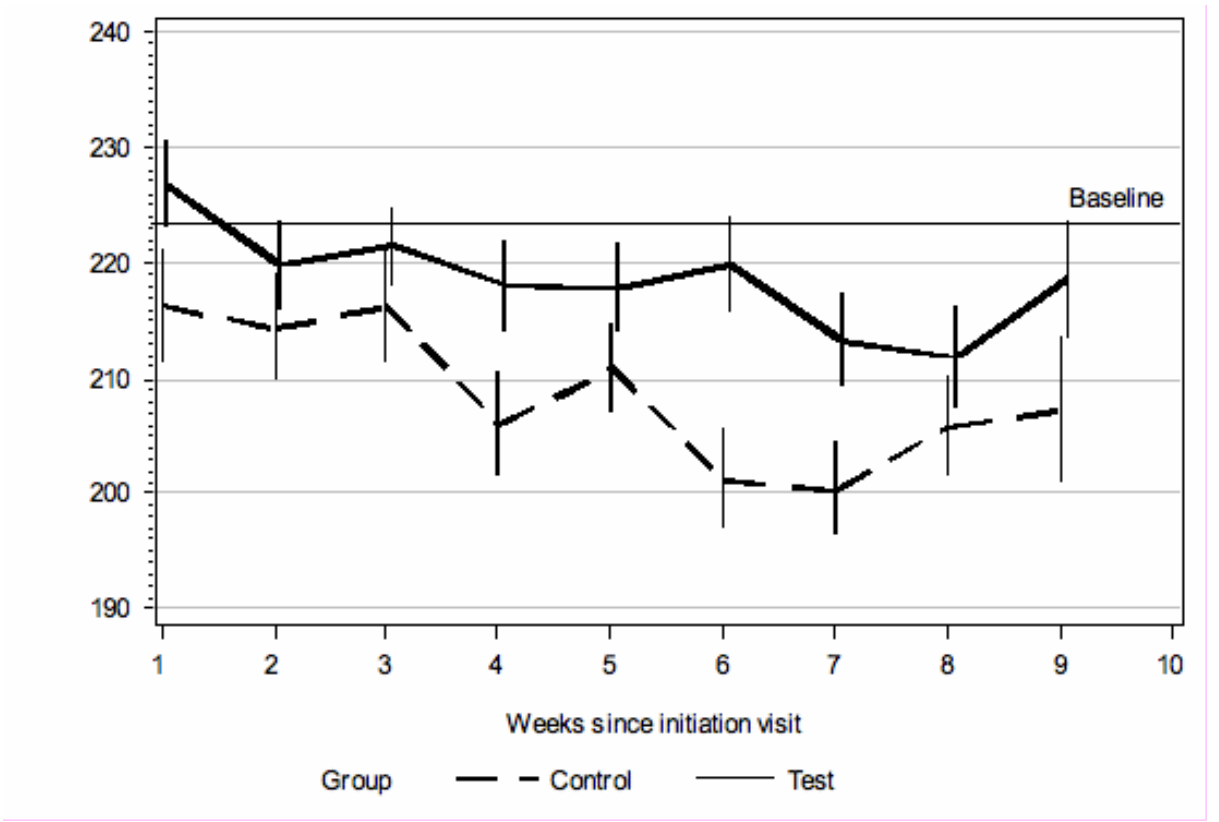
Figure 4. Accelerometer-measured mean number of 2-min epochs spent in moderate intensity MET range (above 3 and up to 6); error bars represent SE; baseline is 3-week average before start of